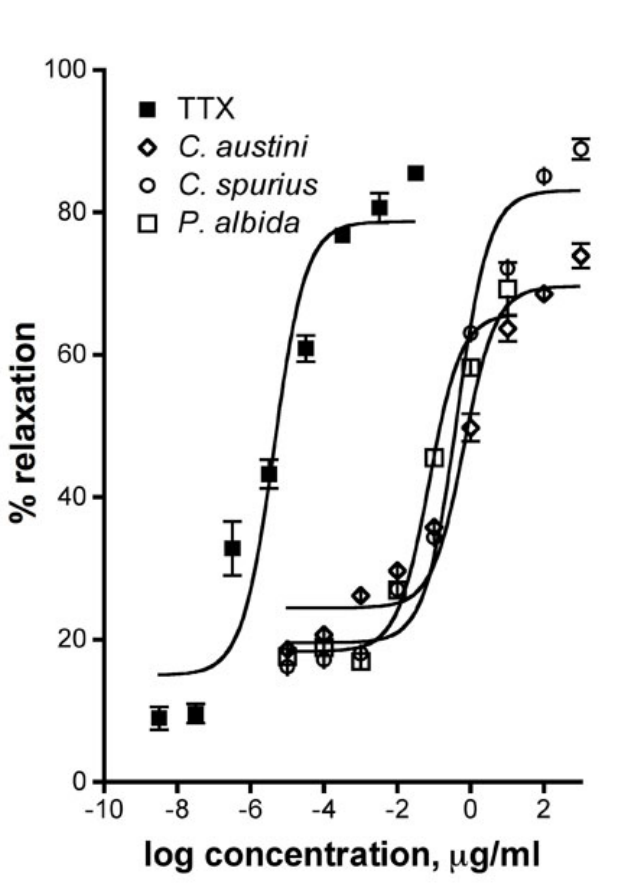
Figure 3. Concentration-response curves for the inhibitory effect of TTX and the venom duct extracts from C. austini , C. spurius and P. albida on the spontaneous contractions of isolated guinea pig ileum. Values are expressed as percent inhibition of contractile response calculated as the mean from six measurements ± SEM. Table 1. Spontaneous contraction inhibition of isolated guinea pig ileum induced by venom duct extracts from C. austini , C. spurius and P.